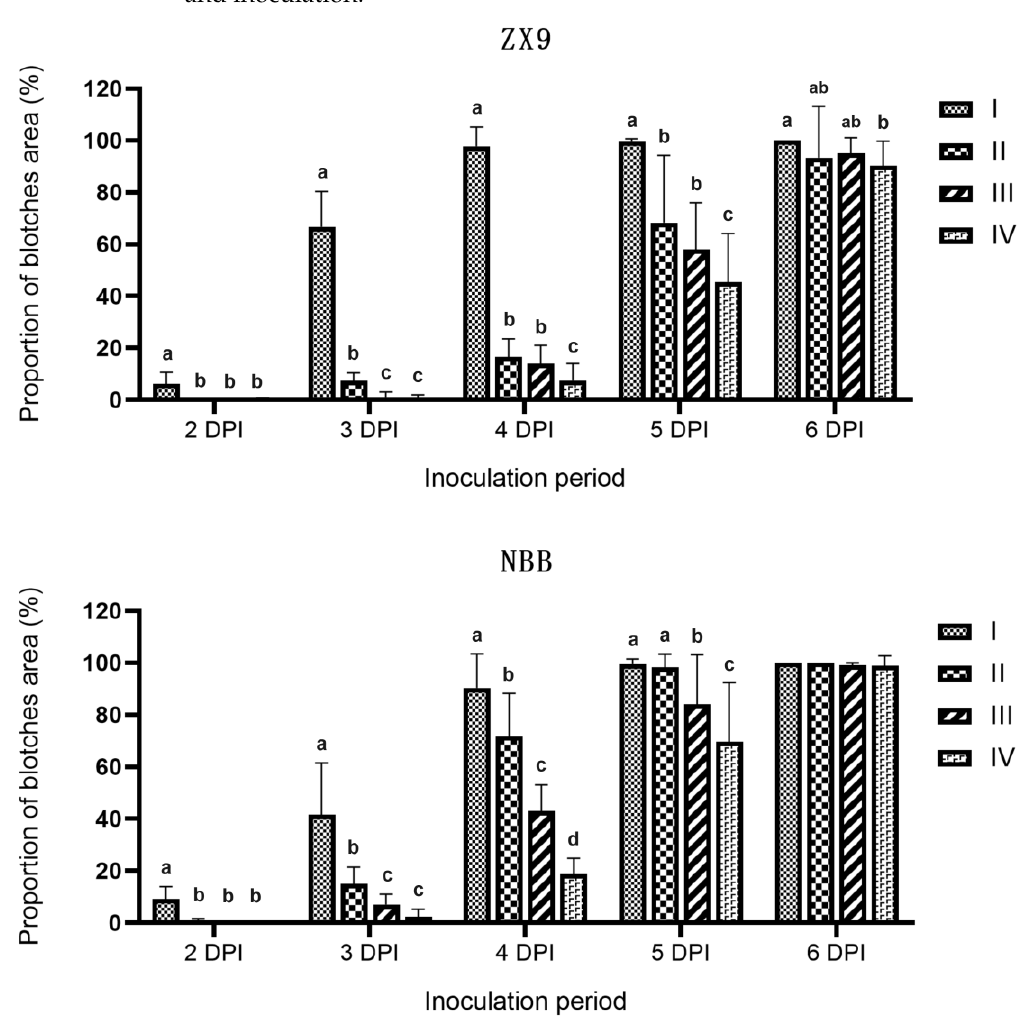
Figure 2. Proportion of the pod surface area covered with blotches 2 to 6 days after inoculation, of the pods at different stages of maturity, of Zhexian No. 9 (ZX9) and Nanhua Black Bean (NBB) soybean, inoculated with mycelial suspension. I, II, III, and IV represent four different stages of maturity, ordered from youngest to oldest. The different letters above the columns indicate significant differences ( p = 0.05) determined by two-tailed t -tests.